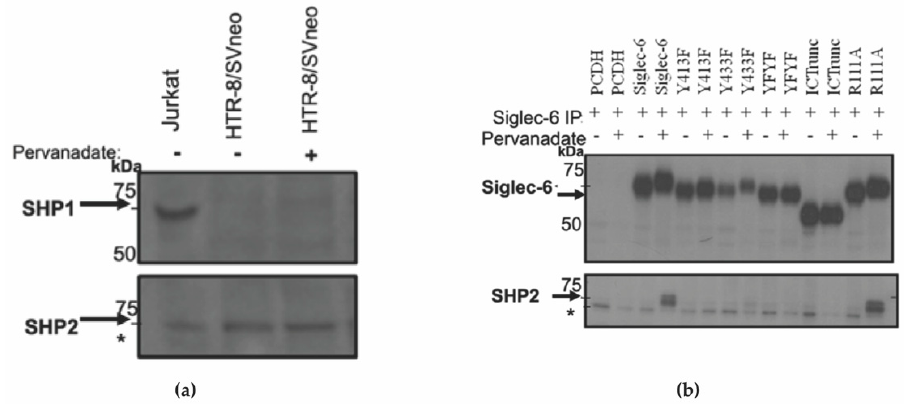
Figure 5. SHP-2 is Recruited to Siglec-6 Following Tyrosine Phosphorylation. ( a ) Whole cell lysates from Jurkat and HTR-8/SVneo treated with and without pervanadate were immunoblotted using anti-SHP-1 (upper panel) and anti-SHP-2 (lower panel) antibodies ( b ) pCDH, Siglec-6, and mutated Siglec-6 were transfected into HTR-8/SVneo cells to generate stable cell lines. Cells were treated with PBS (control) or 100 µ M pervanadate, and lysates immunoprecipitated with anti-Siglec-6 antibody. Co-immunoprecipitates were run on duplicate immunoblots and probed with anti-Siglec-6 or anti-SHP-2 antibodies ( n = 2–4). * A non-specific band was observed across all lanes.